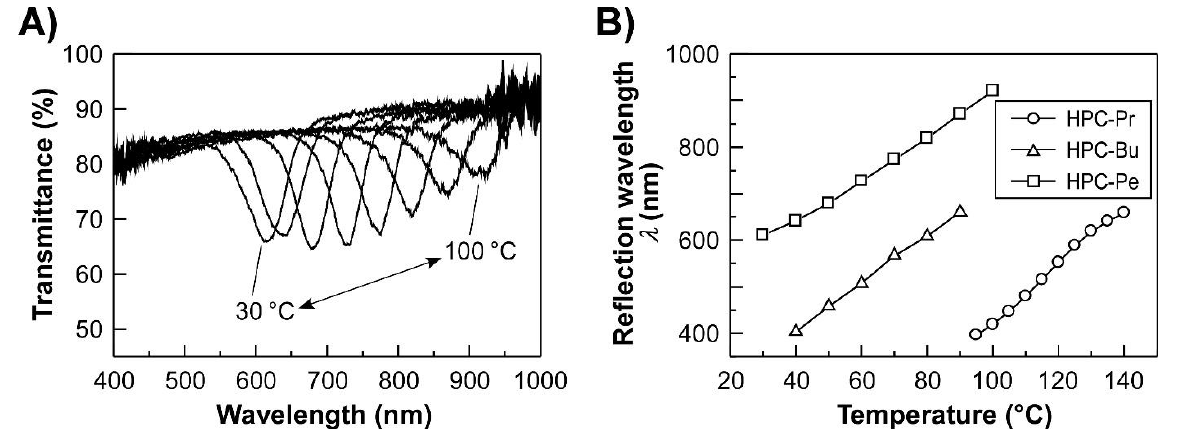
Figure 1. Reflection properties of HPC-Pr, HPC-Bu, and HPC-Pe by temperature. ( A ) Changes in the transmission spectrum of HPC-Pe as a function of the temperature from 30 °C to 100 °C at intervals of 10 °C. ( B ) Temperature dependences of reflection peak wavelengths of HPC-Pr, HPC-Bu, and HPC-Pe.